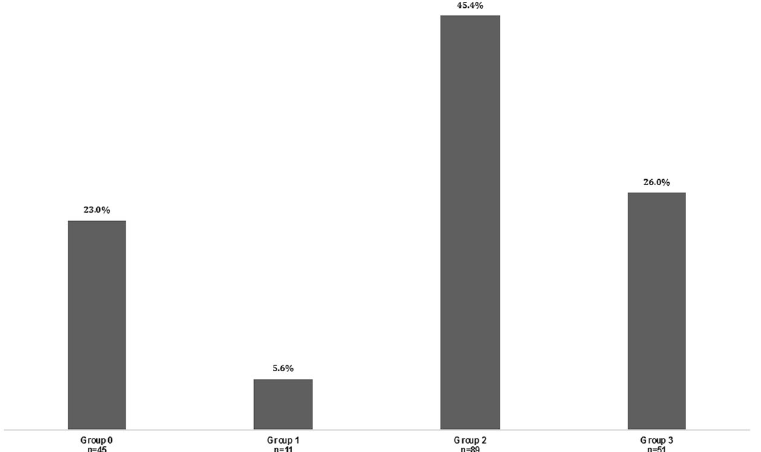
Figure 3. Classification of patients into groups. Group 0: neonates with transient disorder; group 1: neonates diagnosed with IMD confirmed by molecular testing; group 2: neonates suffering from a non-metabolic disease; group 3: neonates with chronic clinical abnormalities but for whom no diagnosis could be made.